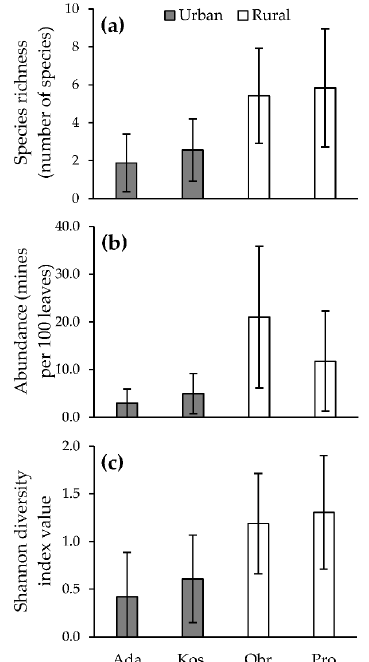
Figure 1. Effect of study site and habitat type on: ( a ) species richness, ( b ) abundance, ( c ) diversity of leaf miners (mean ± s.d.) (Ada = Ada Ciganlija, Kos = Košutnjak, Obr = Obrež, Pro = Progar).